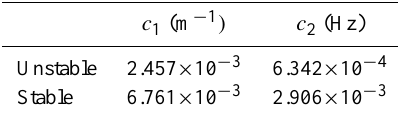
Table A1. Values for the constants used in Eq. (A4).